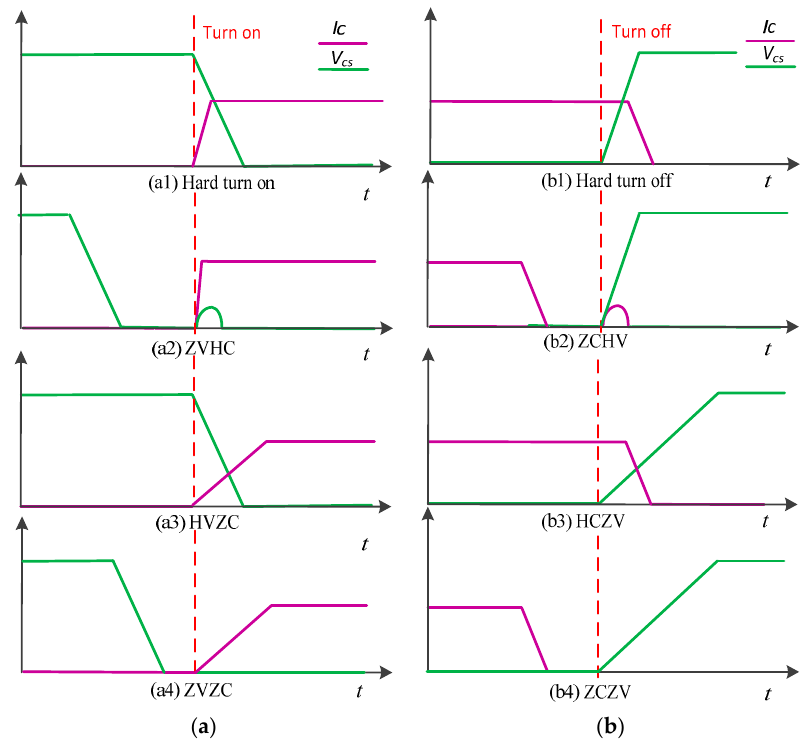
Figure 1. Turn-on and turn-off switching classification ( a ) Turn-on; and, ( b ) Turn-off.